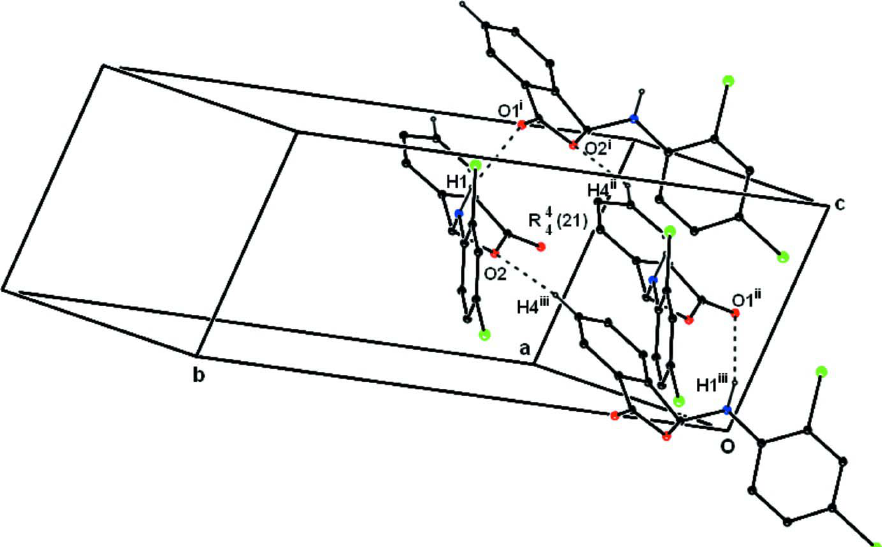
Figure 2 A partial packing diagram of (I), showing the formation of R [symmetry codes: (i) x, 1/2 - y, z + 1/2; (ii) x - 1, y, z; (iii) x - 1, 1/2 - y, 1/2 - z]. H atoms not involved in hydrogen bondings have been omitted for